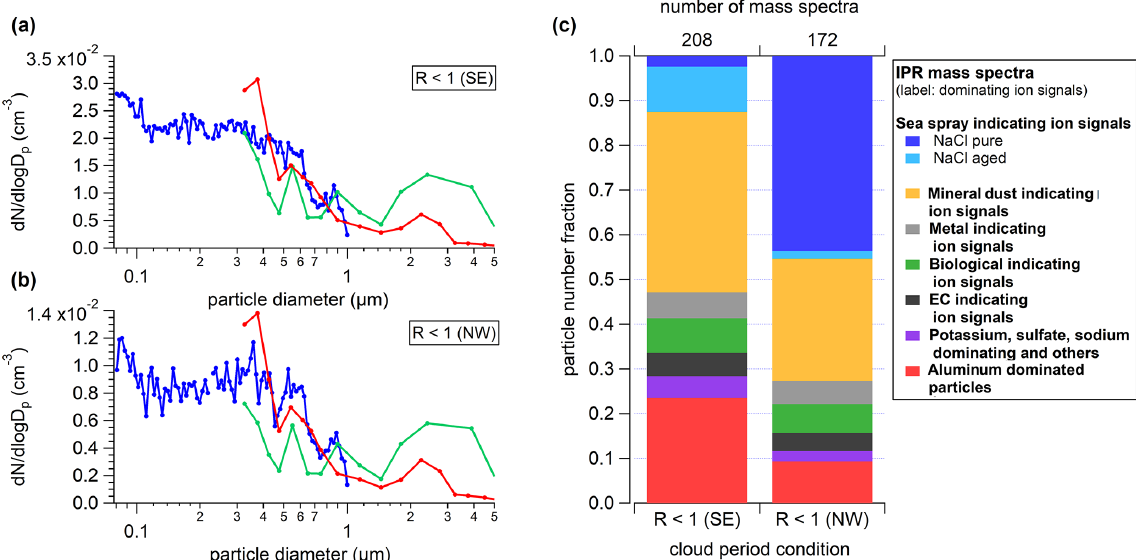
Figure 9. Comparison of the IPR number size distribution of cloud periods with a higher ( R < 1) proportion of small IPRs ( < 300nm), which is interpreted as higher contribution of secondary ice (see description in Sect. 3.5.1) as a function of air mass flow direction, in the case of a southeasterly flow ( SE, a) and northwesterly flow ( NW, b) , and respective IPR composition (c) . The size distributions shown in panels (a) and (b) were measured using a UHSAS (blue), an OPS (green), and a Sky-OPC (red). The IPR composition shown in (c) was determined with the